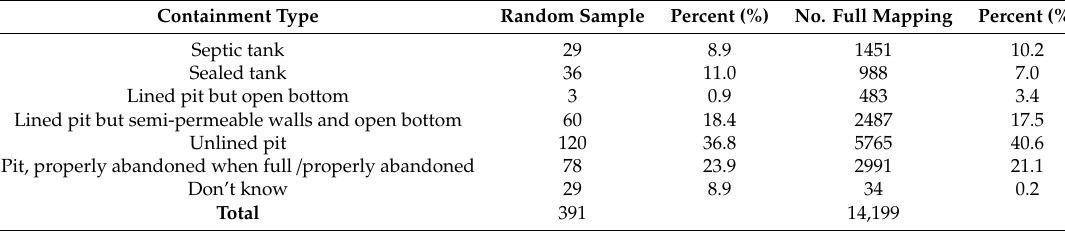
Table 6. Comparison of sanitation